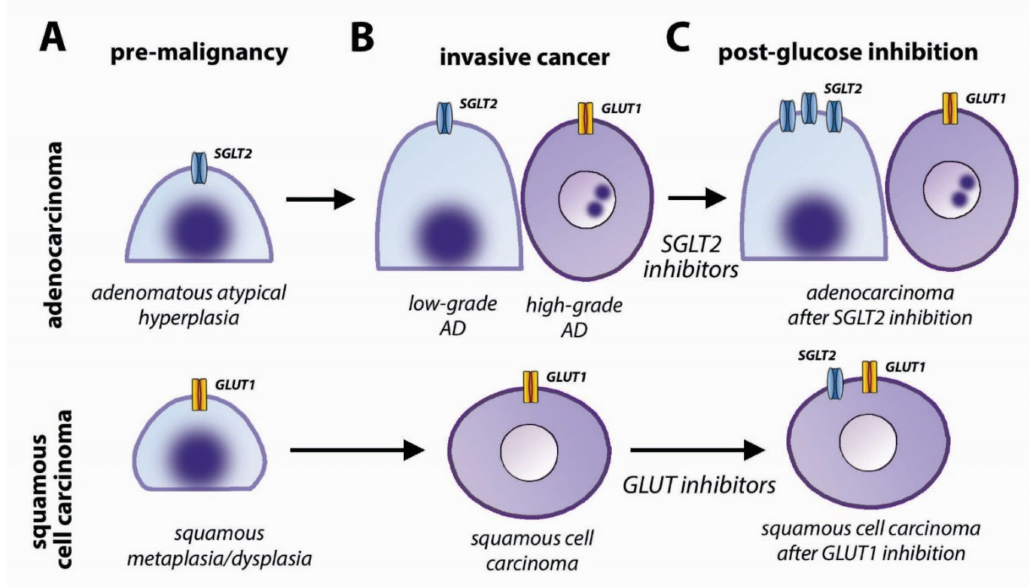
Figure 5. Heterogeneity of glucose transport in lung cancer. Schematic representation of glucose transporter expression in the two most frequent types of lung cancer: adenocarcinoma (upper panels) and squamous cell carcinoma (lower panels). The figure presents the major glucose transporters expressed in di ff erent stages of cancer development. ( A ) premalignant lesions; ( B ) Invasive cancer; and ( C ) invasive cancer after therapy with glucose transport